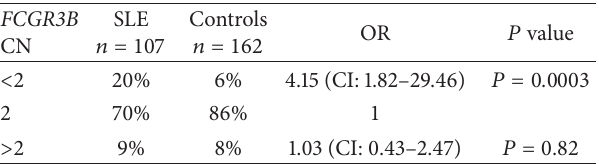
Table 1: Frequency of copy number (CN) variation in the FCGR3B gene in SLE patients and controls. Odds ratios with 95% confidence intervals (CI) for the association between FCGR3B gene copy number (CN) and SLE. Reference group is healthy controls ( 𝑛 = 162